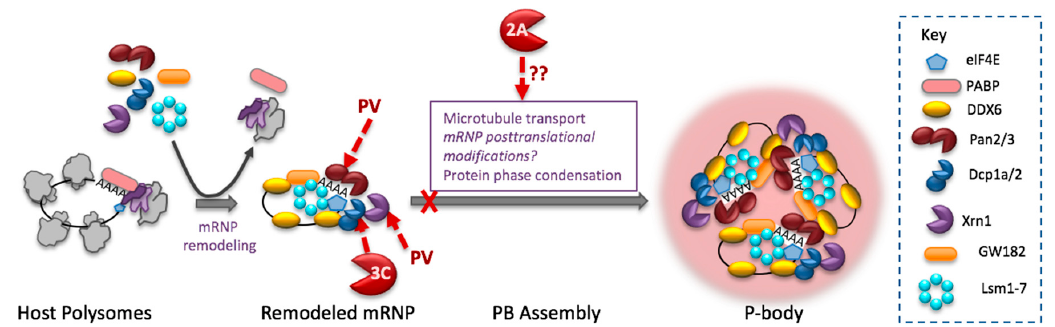
Figure 2. Enterovirus inhibition of P-bodies. Cartoon depicts mRNP remodeling required for assembly into PBs and cleavage of PB factors that destabilize mRNA. Pan 3 and Dcp1a play roles in PB formation. 2A pro blocks PB formation through an unknown mechanism(s).